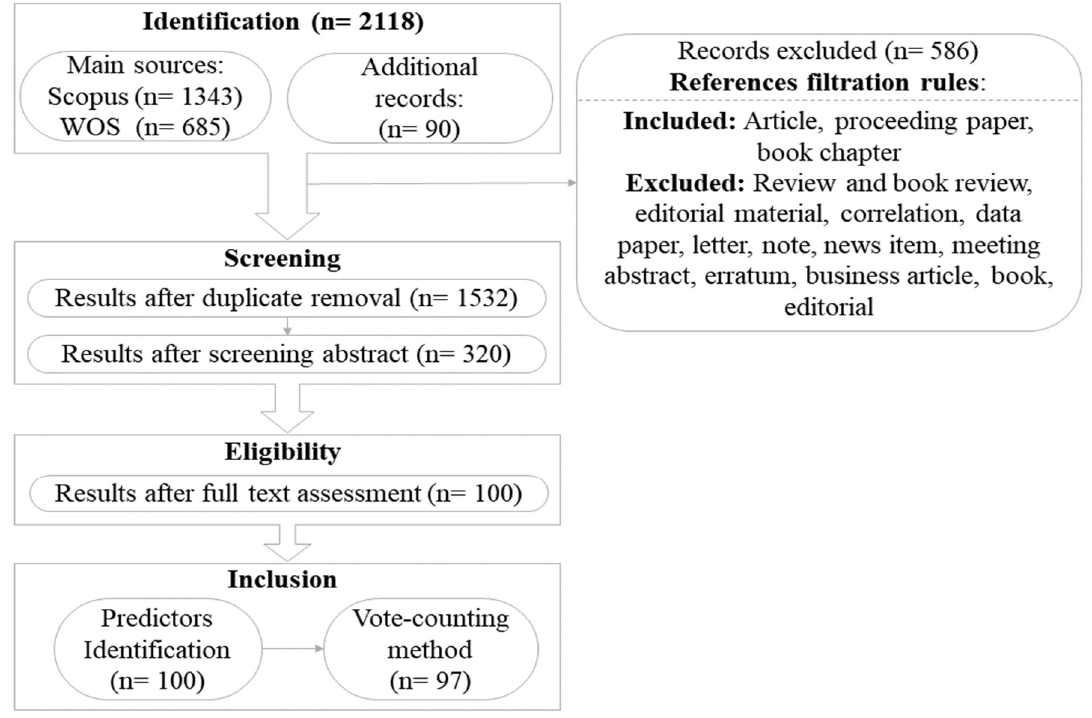
Figure 1. PRISMA flowchart depicting the stages of the study selection procedure [17].